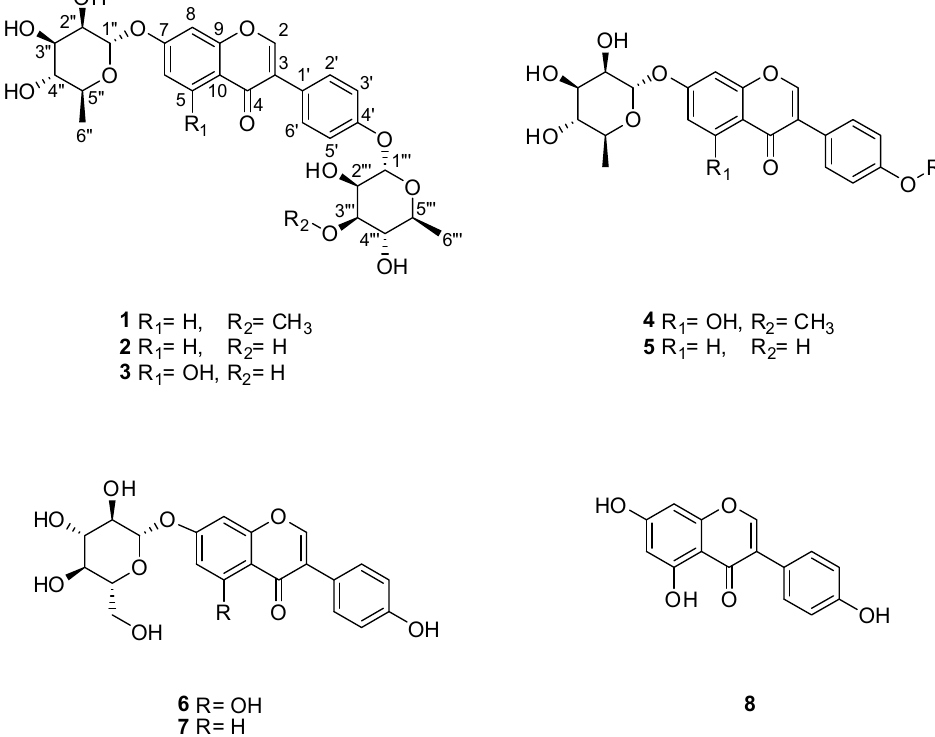
Figure 1. The chemical structures of compounds 1–8 .